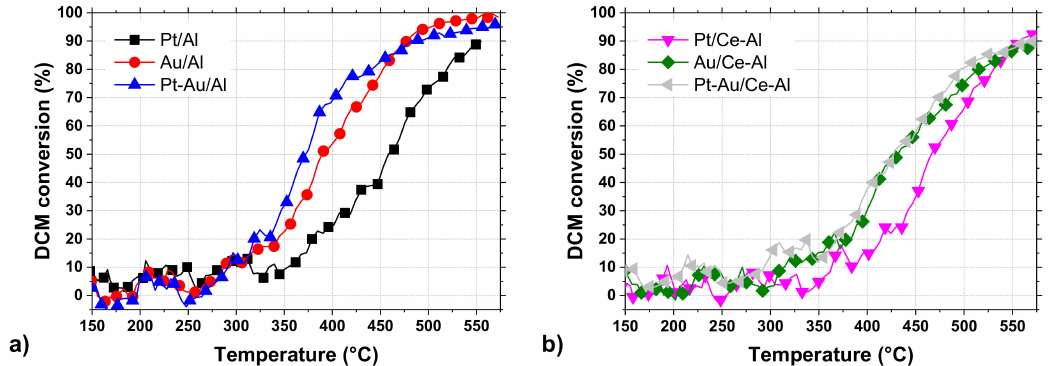
Figure 5. Dichloromethane (DCM) conversion of the Pt, Au, and Pt-Au catalysts supported on ( a ) Al 2 O 3 and on ( b ) CeO 2 -Al 2 O 3 (DCM 500 ppm, H 2 O 1.5 vol.%, weight hourly space velocity (WHSV) 720 g g cat − 1 h − 1 ). Table 4. Summary of the catalytic performance and selectivity of all the tested catalysts in